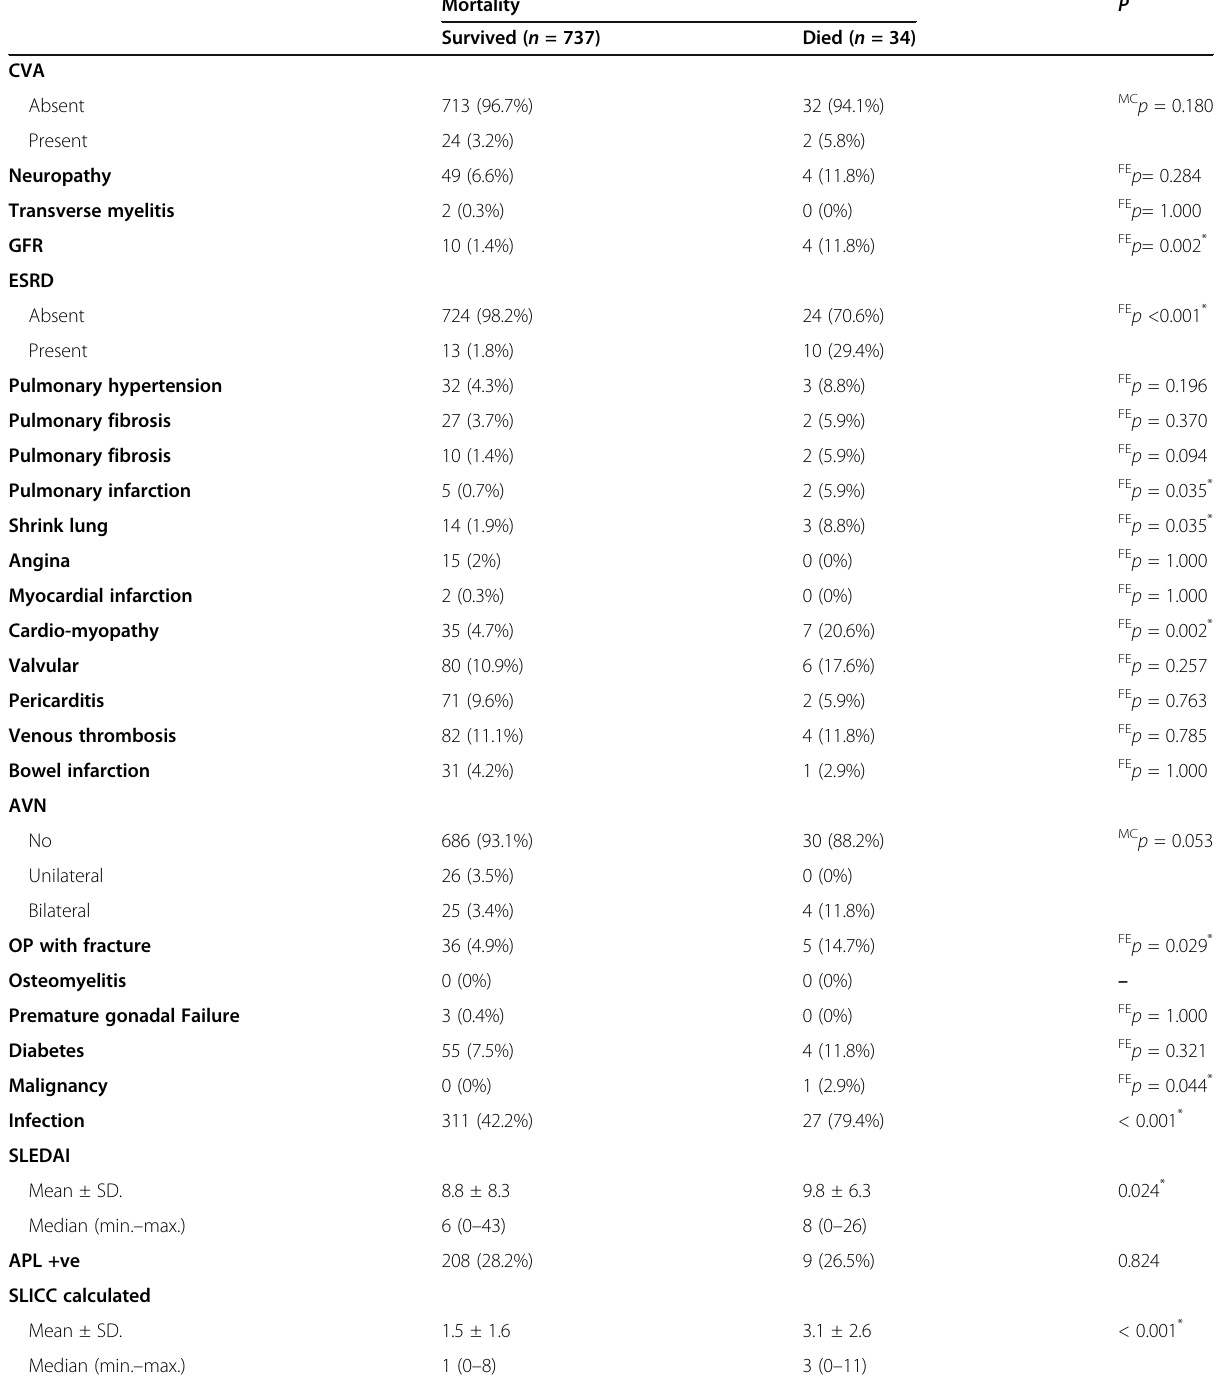
ESRD End-stage renal disease, CVA Cerebrovascular accident, GFR Glomerular filtration rate, AVN Avascular necrosis, OP Osteoporosis, APL Antiphospholipid antibodies, SLICC Systemic Lupus International Collaborating Clinics Damage Index score, SLEDAI SLE Disease Activity Index, χ 2 Chi-square test, FE Fisher exact, MC Monte Carlo, p P value for association between different categories *Statistically significant at p ≤